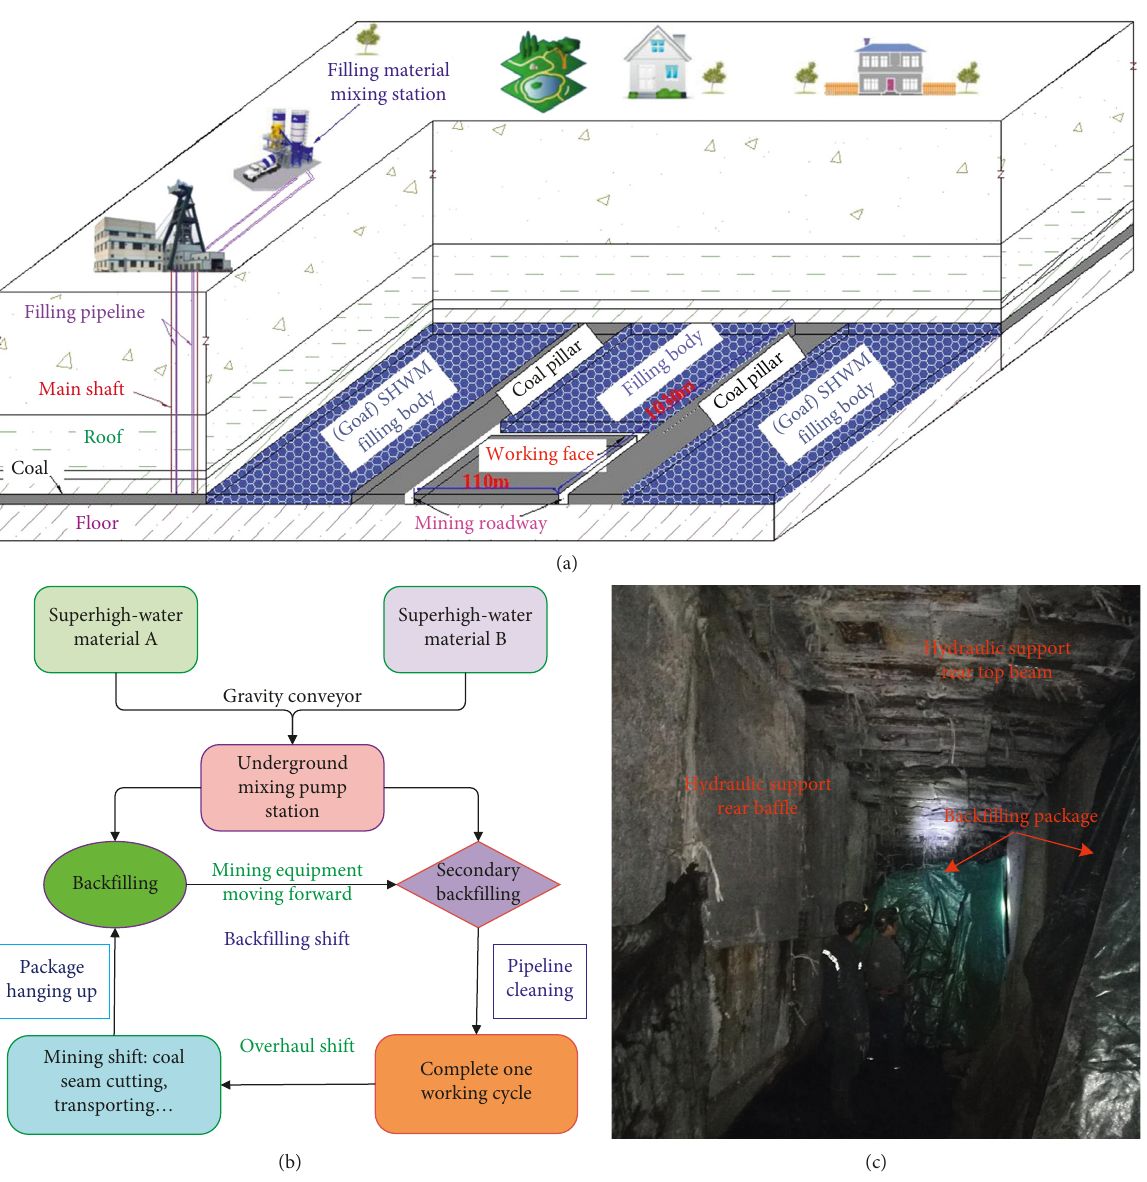
Figure 2: SHWM backfilling procedure and its application. (a) SHWM backfilling for the “Three Under Mining.” (b) Procedure of SHWM backfilling technology. (c) Field experiment of SHWM backfilling